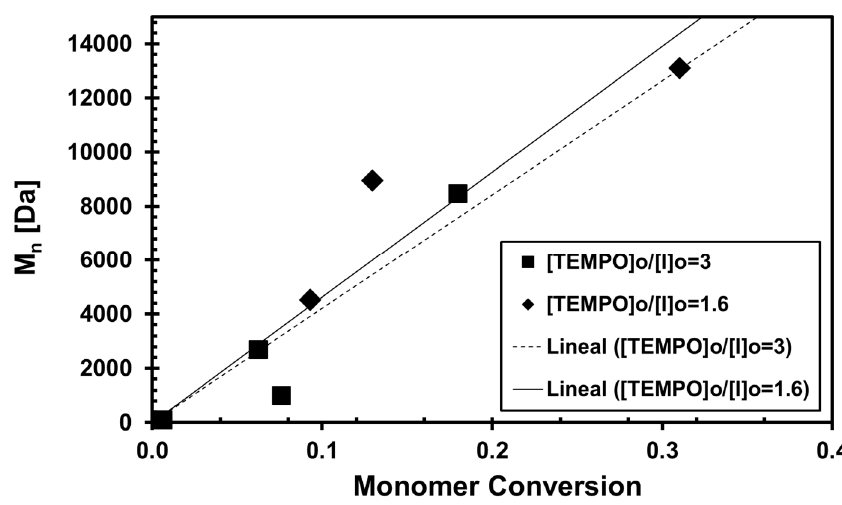
Figure 9. Effect of controller content on the evolution of M n versus conversion for the NMC of STY/DVB in scCO 2 at [DVB] = 1 wt.%, T = 120 °C, and P = 207 bar.